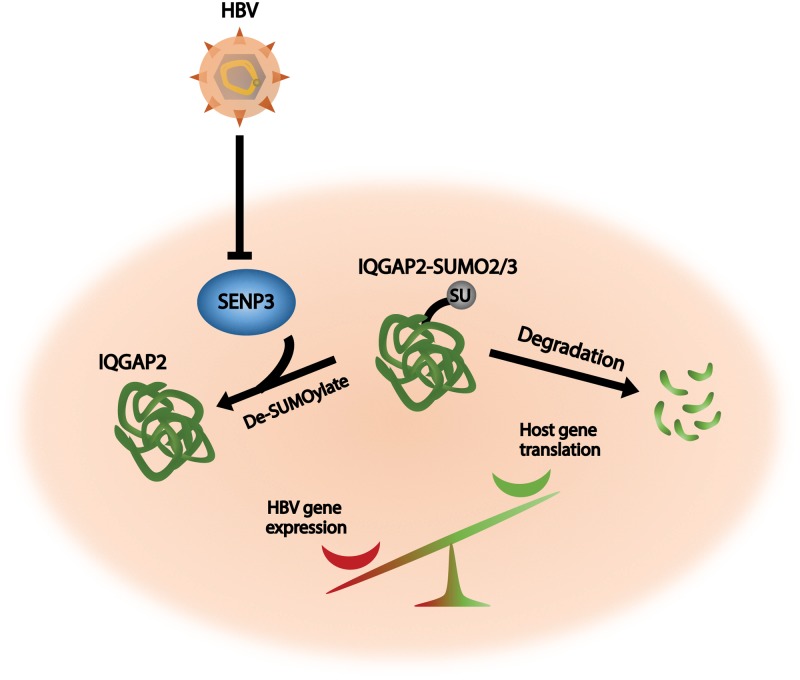
Graphical summary.Upon hepatitis B virus (HBV) infection, hepatocytes downregulate SENP3 to promote SUMOylation and subsequent degradation of IQGAP2. The SENP3-IQGAP2 de-SUMOylation axis is a host defense mechanism that restores host protein translation and suppresses HBV gene expression.